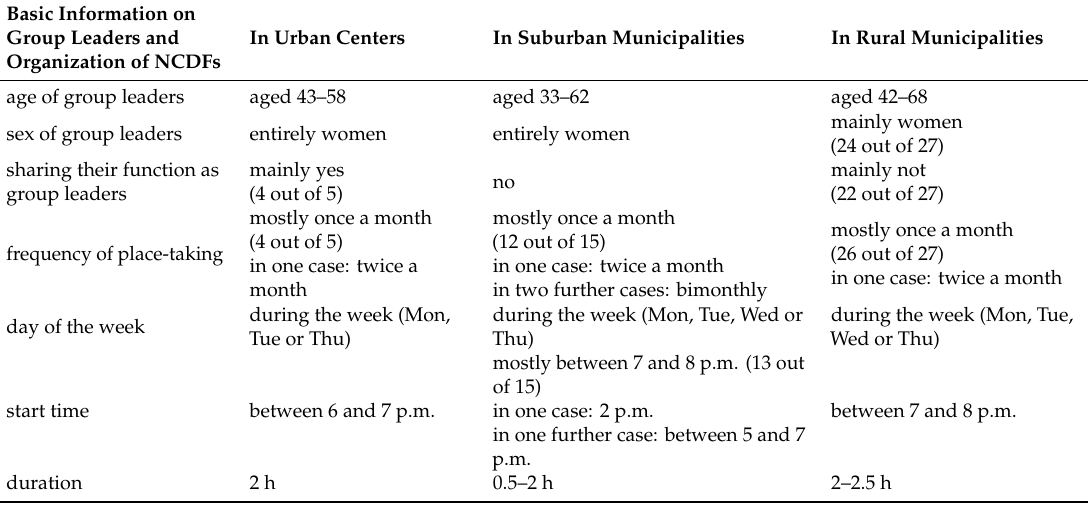
Table 3. Breakdown of basic information on